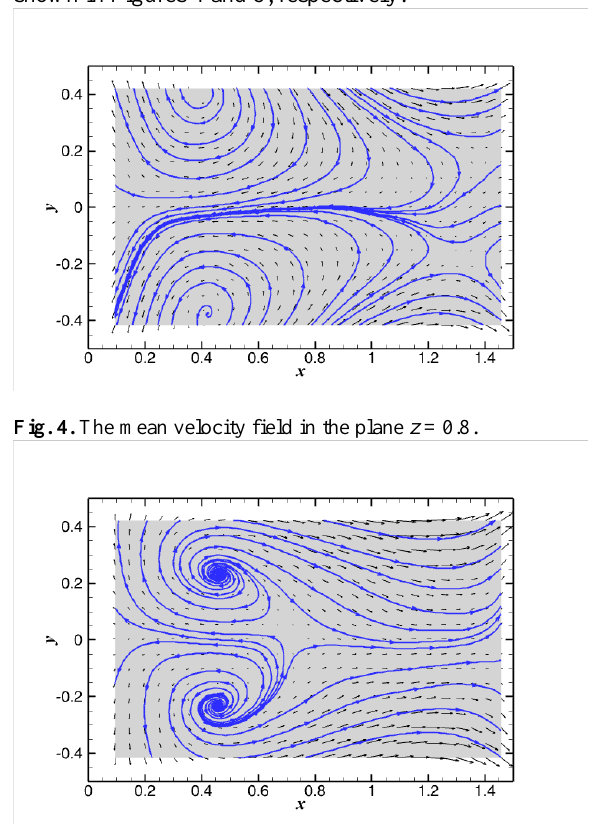
Fig. 5. The mean velocity field in the plane z = 1 .